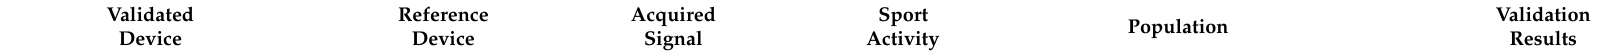
Table 1. Validation studies characterized by the validated device, the reference device, the acquired signal (ECG and/or HR), the practiced sport activity, the population characteristics and the validation results. Devices are reported with their commercial name and the population characterized in terms of sex (male/female), age, ethnicity and BMI. If not, present height and weight are reported. Information not available is reported as “-”.